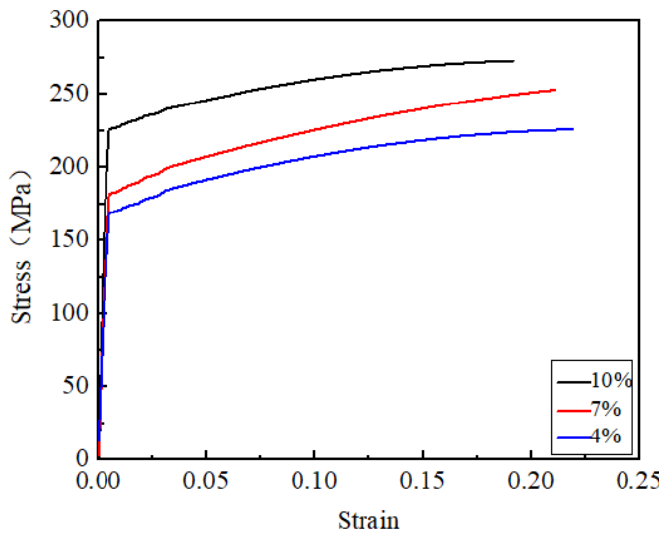
Figure 6. The stress-strain curves of the samples (4%, 7%,